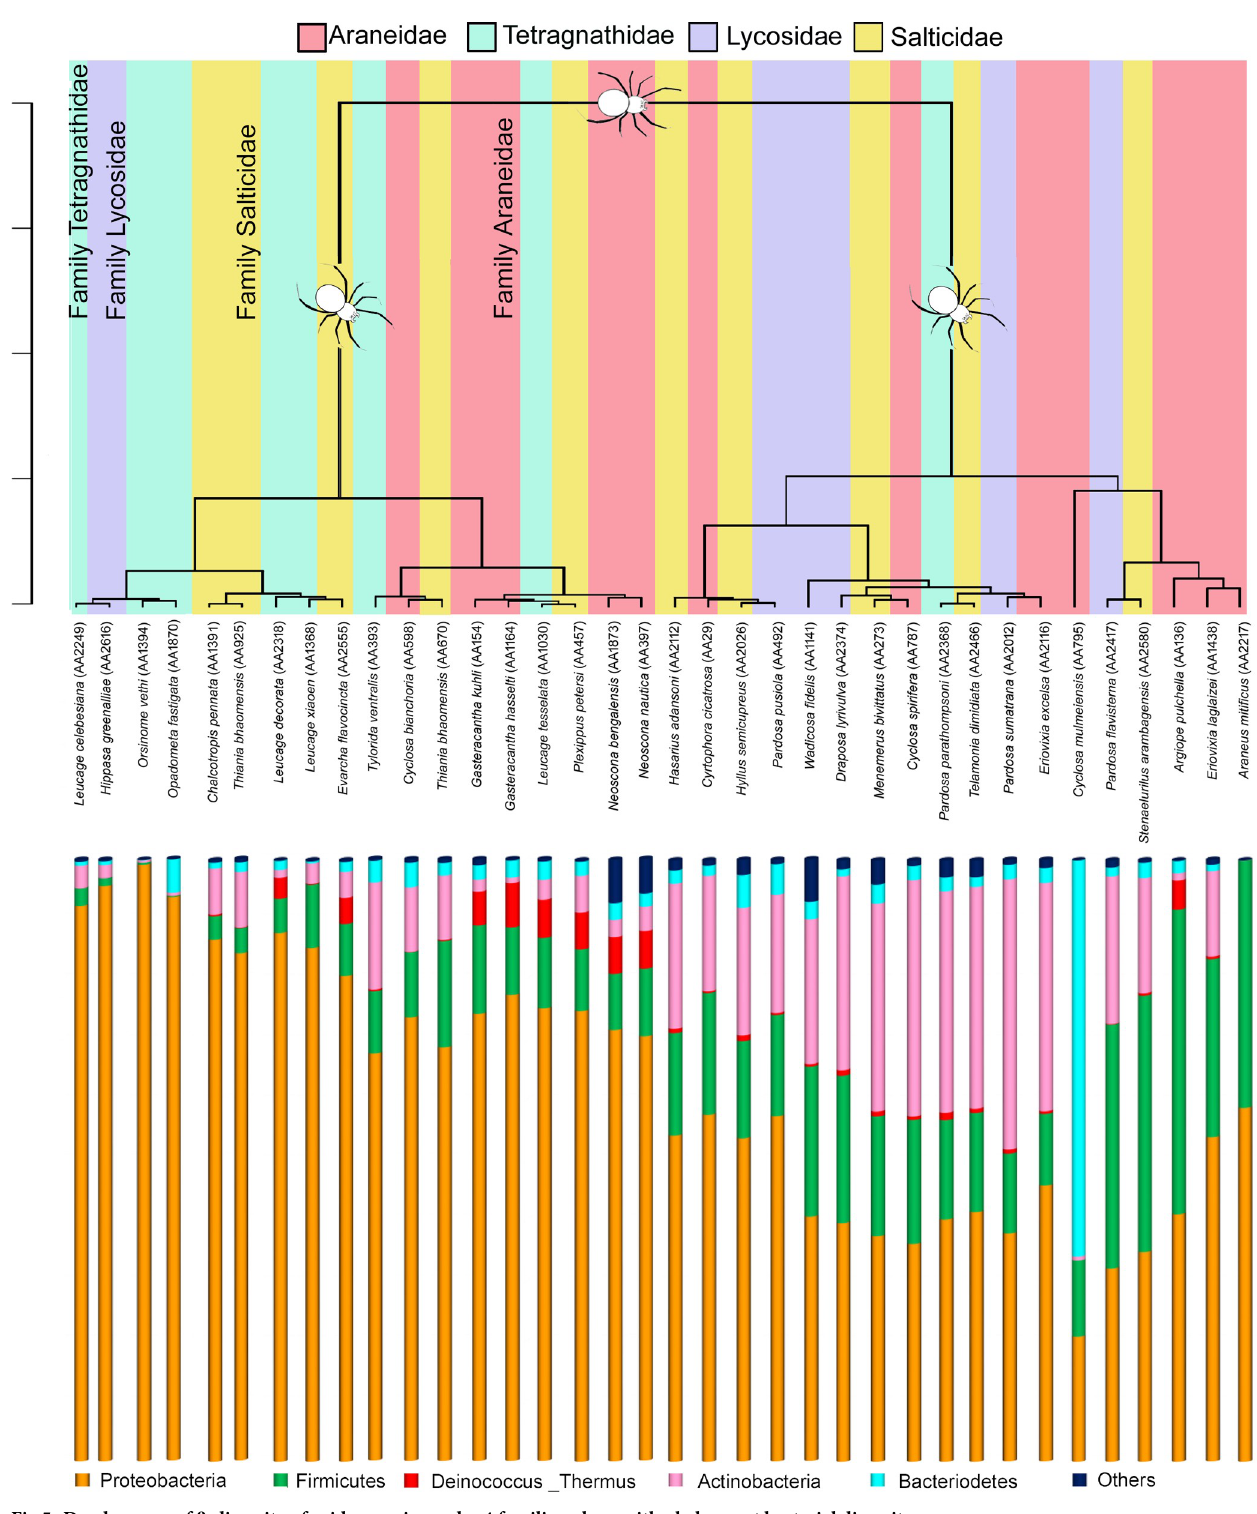
Fig 5. Dendrogram of β -diversity of spider species under 4 families, along with phylum gut bacterial diversity.